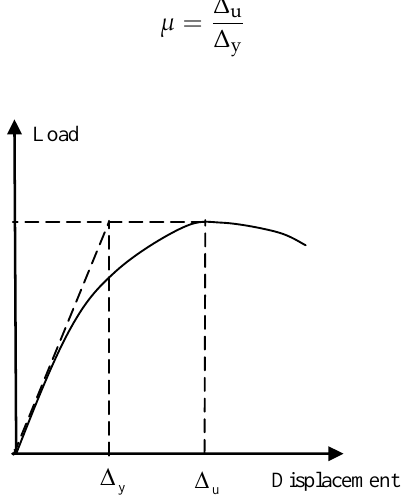
Figure 16. Method of determining ductility